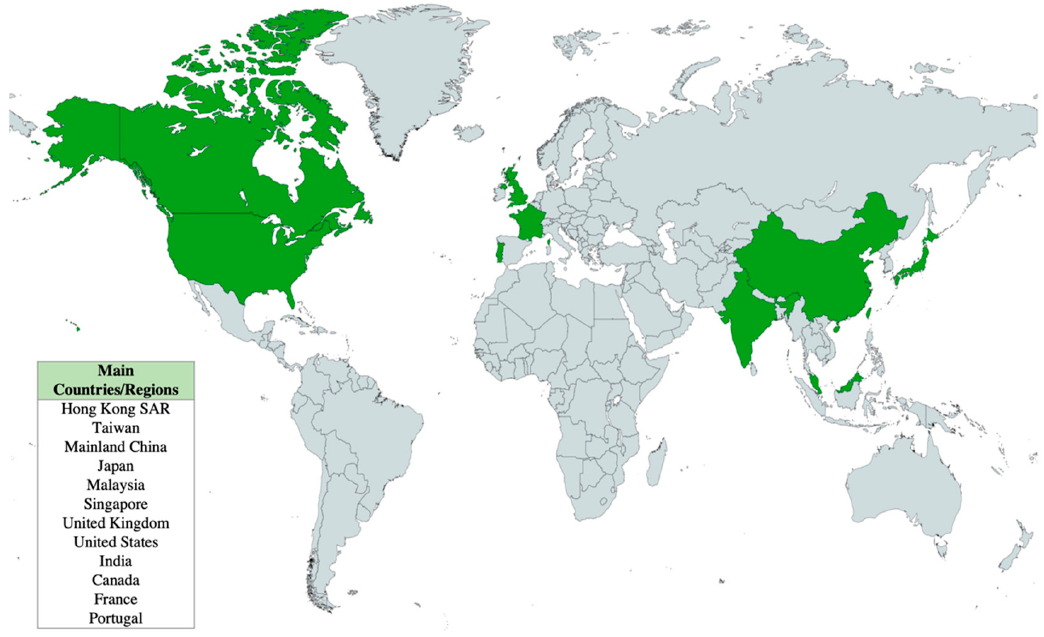
Figure 4. Locations of Caritas Aberdeen IFSC’s online Zentangle workshop viewers.